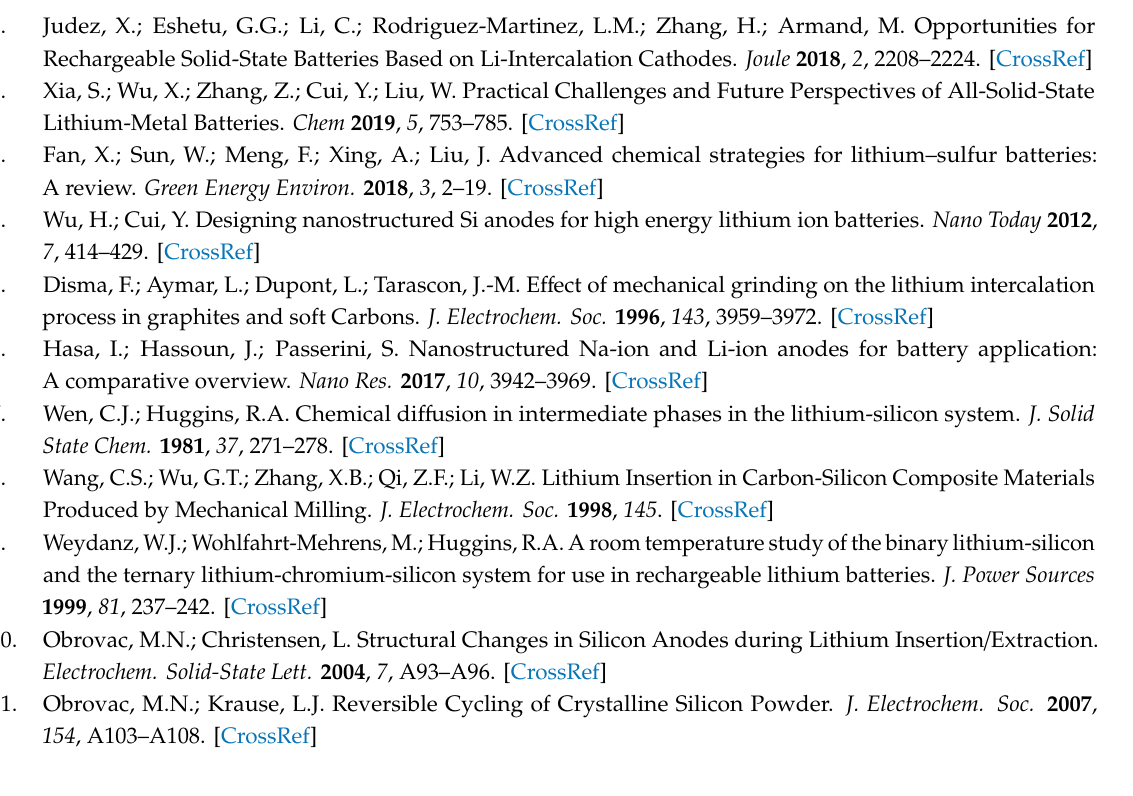
at 28 ◦ , Figure S1: XRD pattern of the dry milled graphite (M-G), Figure S2: Raman spectrum of the dry milled graphite (M-G), Figure S3: SEM images of graphite and dry milled graphite (M-G), Figure S4: EDX elemental mapping of pristine electrodes, Figure S5: SEM image of Si@G synthesized following the wet conditions without the addition of IPA and SEM cross section image of the corresponding electrode, Figure S6: Di ff erential capacity profile of